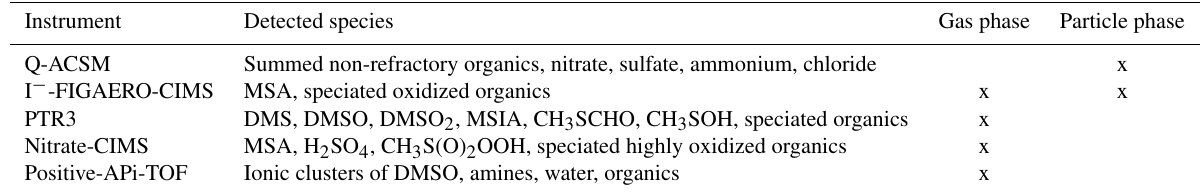
Table 1. An overview of the mass spectrometers used during the SALTENA campaign and their respective detected species. Instrument Detected species Gas phase Particle